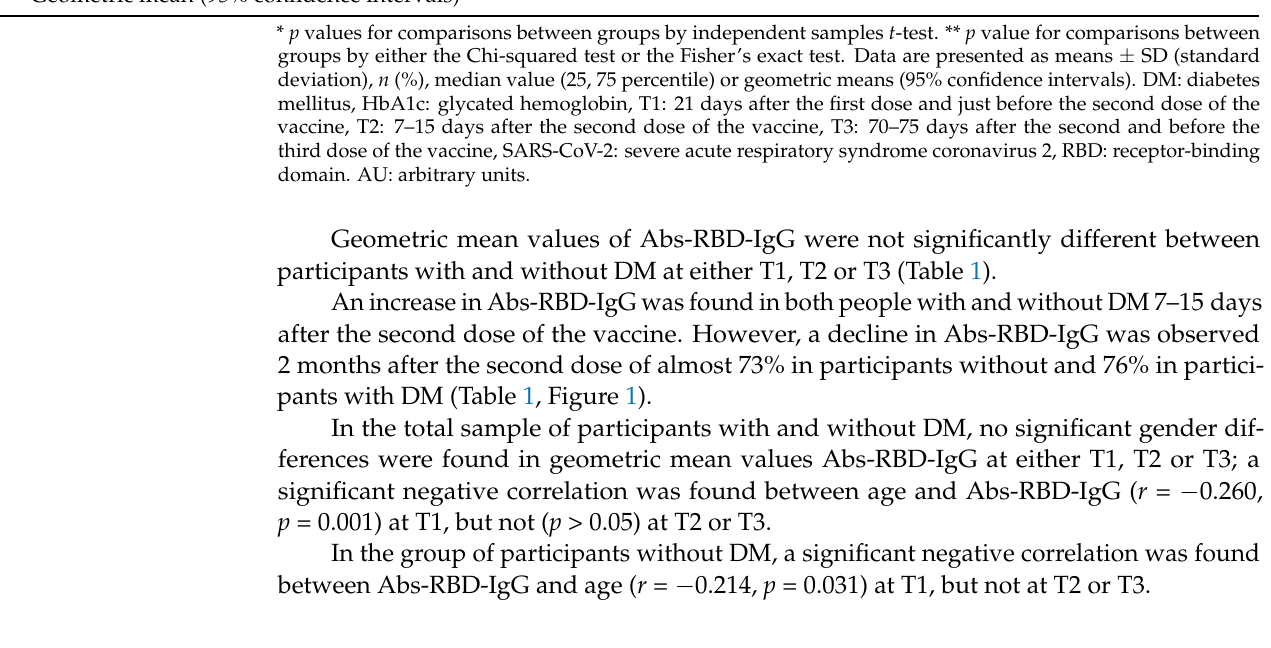
People without DM People with DM n = 116 n =